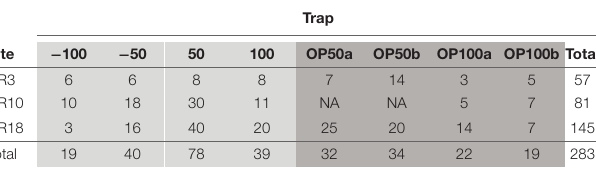
Trapsinlightgrayshadingarelocatedintheriparianreserveandtrapsindarkgrayshading are located in the oil palm